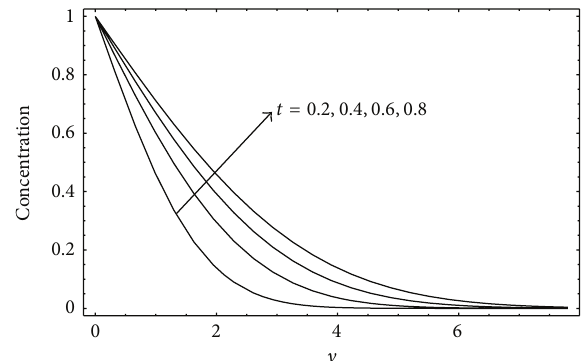
Figure 15: Concentration profiles for different values of 𝑡 when Sc = 0.22 .